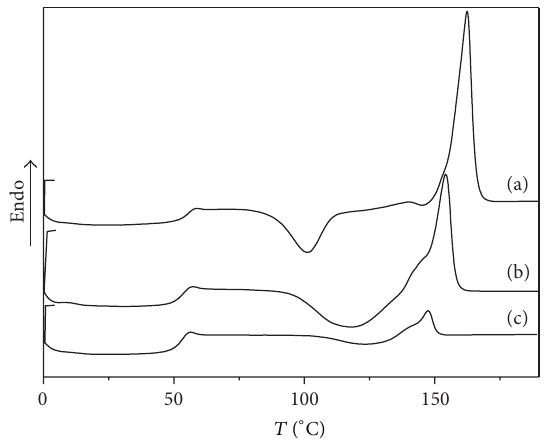
Figure 4: Differential scanning calorimetry thermograms of the obtained P(LA- co -BMD). (a) P(LA 98 - co -BMD 2 ), (b) P(LA 95 - co - BMD 5 ), and (c) P(LA 92 - co -BMD 8